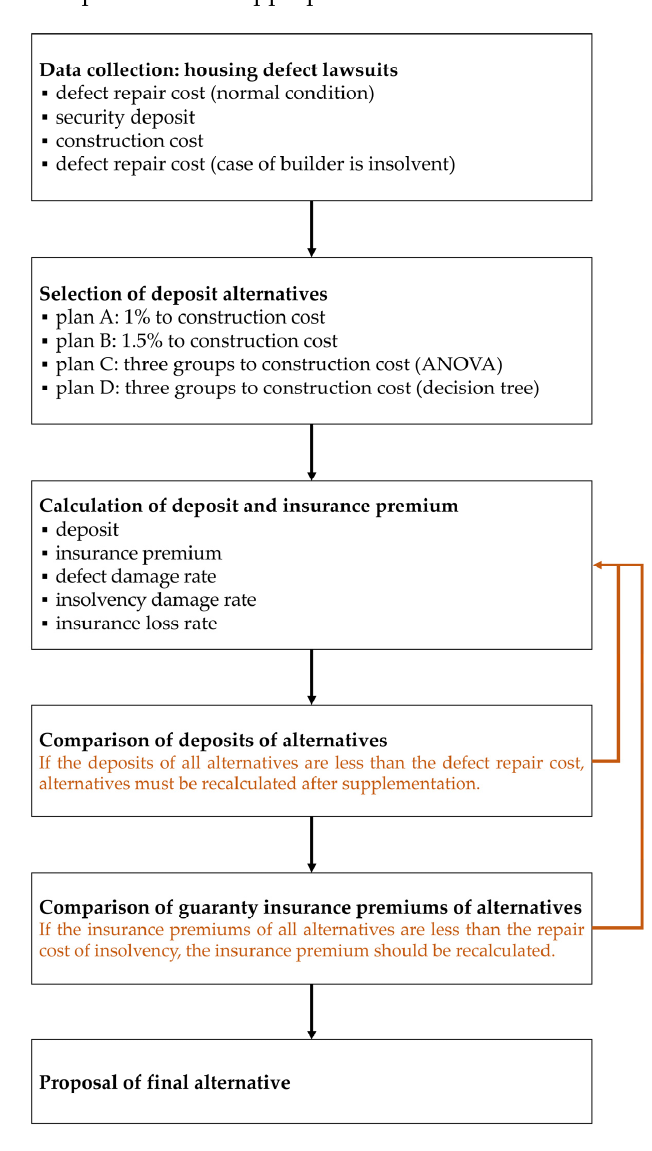
Figure 1. Research framework.